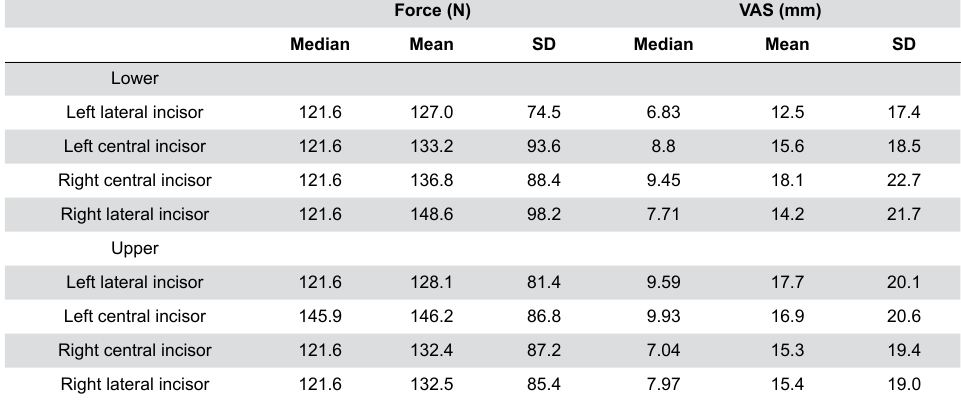
Table 4- Force (N) and VAS score in incisors